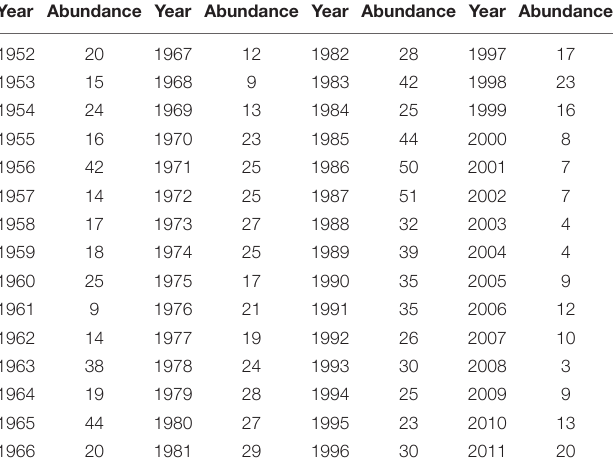
TABLE 3 | Annual average abundance of Atlantic cod at site